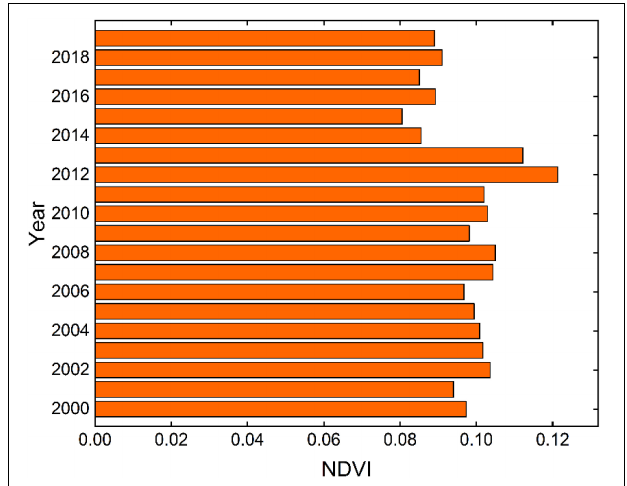
FIGURE 1 | Bar chart of interannual NDVI